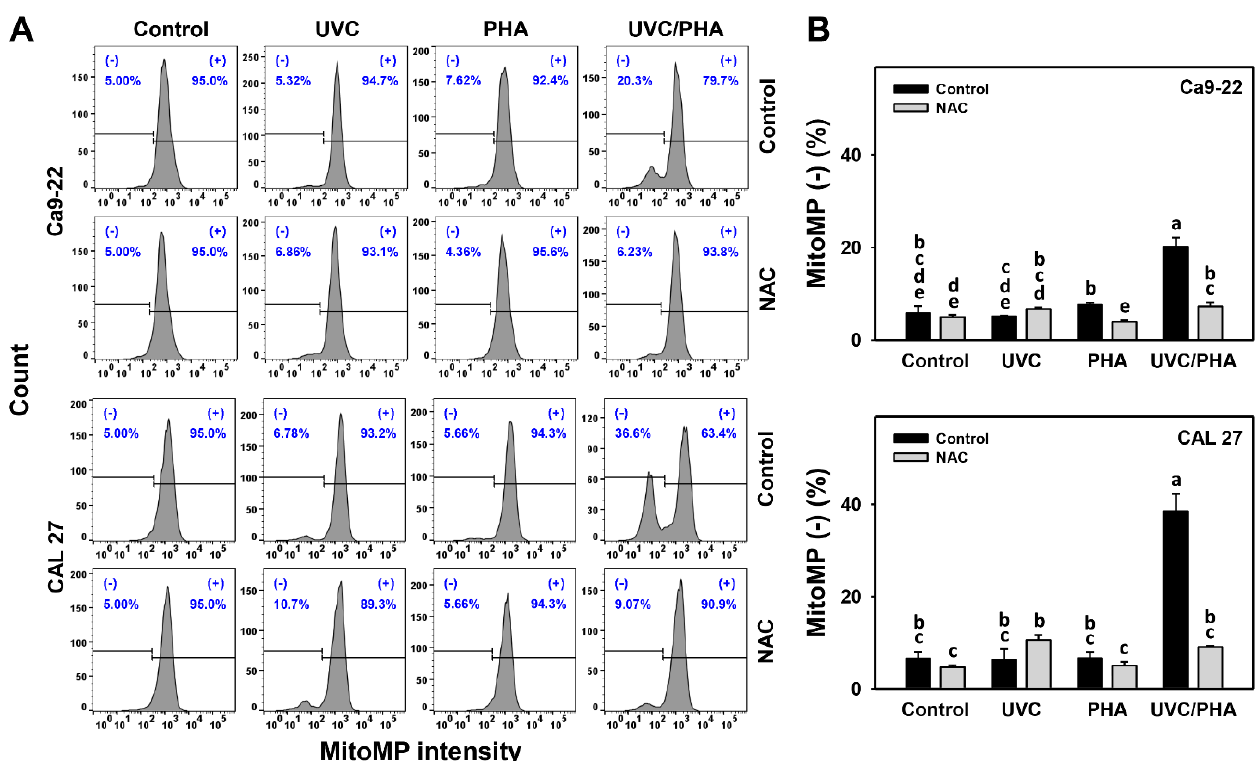
Figure 7. UVC/PHA-induced MitoMP depletion in oral cancer cells. In the presence or absence of NAC, oral cancer cells were grouped into four treatments, i.e., control, UVC, PHA, and UVC/PHA, for 24 h. The doses for the UVC and PHA treatments were 8 J/m 2 and 0.8 μ M, respectively. ( A , B ) Profile and data. ( − ) (%) indicates MitoMP-negative (%). For comparison, treatments labeled with different letters (a to e) produced significantly different results ( p < 0.05). Data are presented as mean ± SD ( n = 3 independent experiments, with each experiment involving 5000 gated cell counts).